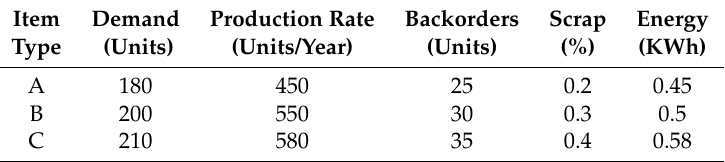
Table 1. Data related to the production and